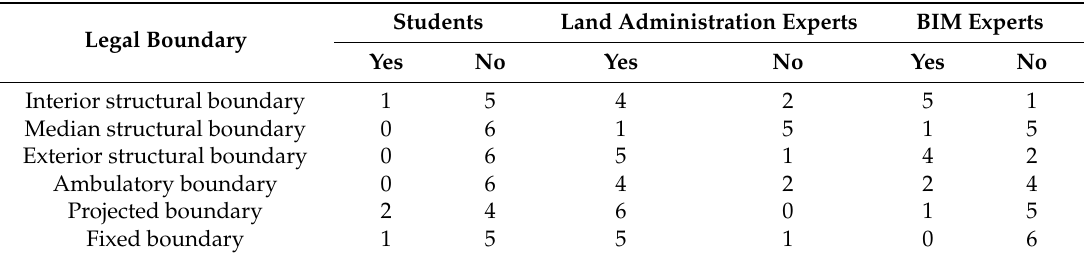
Table 3. Responses to visual understanding of legal boundaries in the purely legal model.